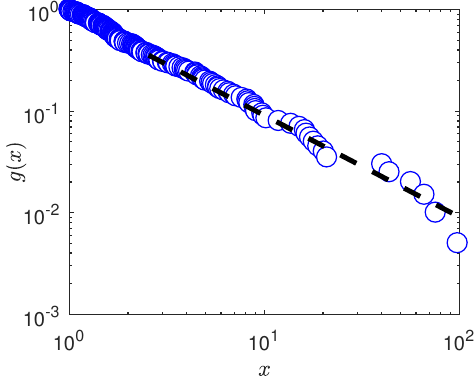
Figure 11. Nodes in power-law distribution.